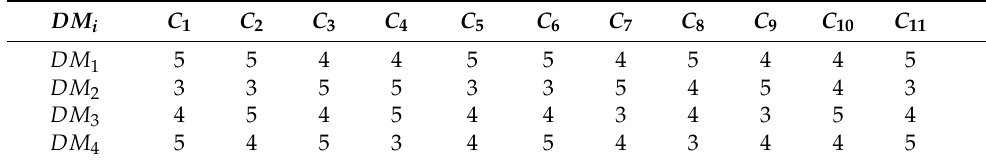
Table 1. Linguistic evaluation for rating criteria.